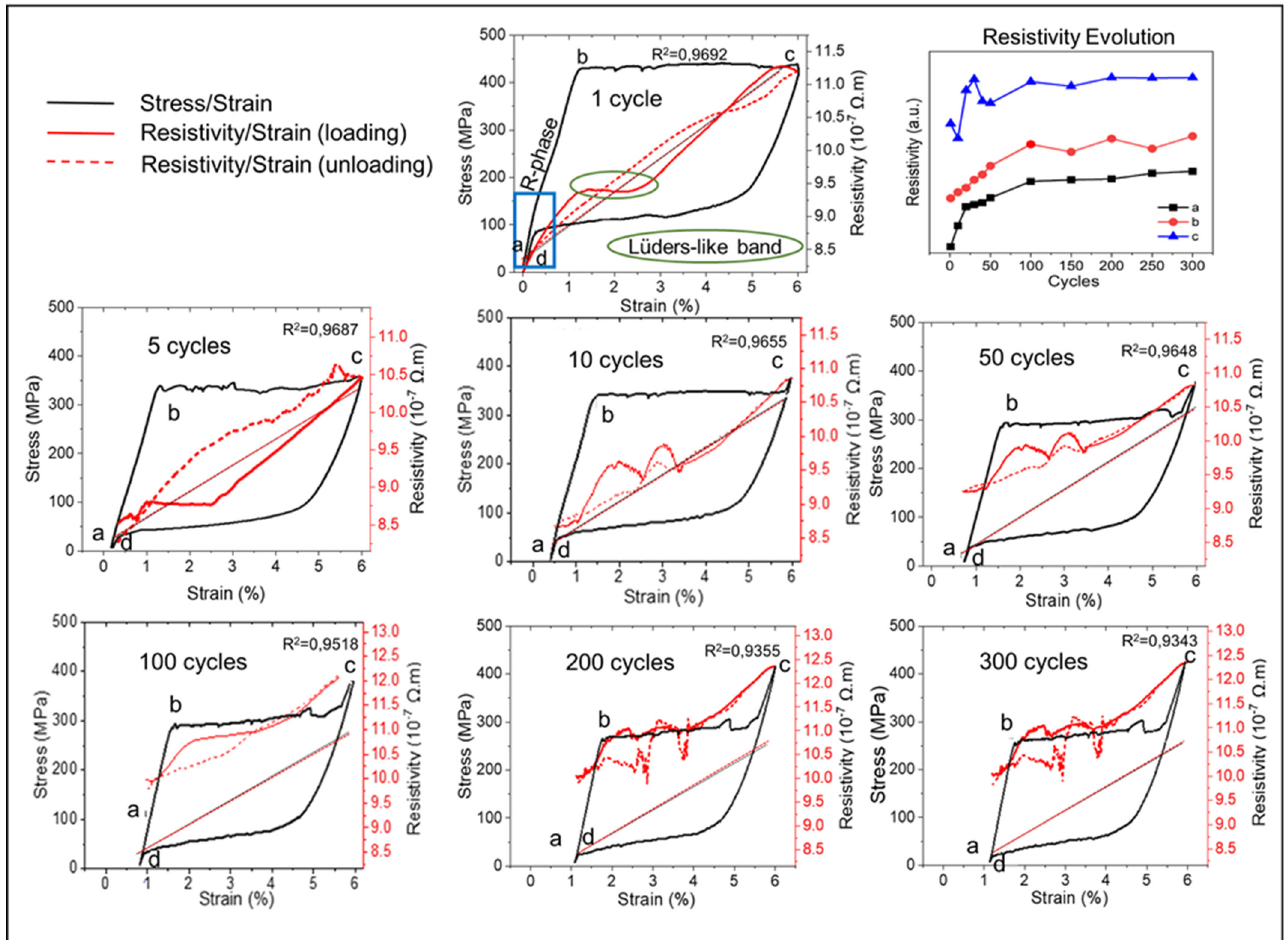
Figure 4. Evolution of stress-deformation (black curves) and resistivity-deformation (red curves) of the NiTi wire in the superelastic low-cycle fatigue test: 1st, 5th, 10th, 50th, 100th, 200th and 300th cycles (a-beginning of each load/unload cycle; b-beginning of the phase transformation plateau; c-end of the phase transformation plateau; d-end of each cycle).